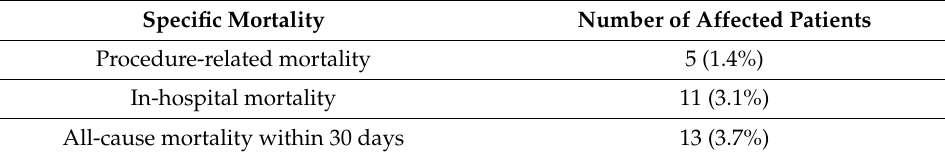
Table 4. Mortality after transvenous lead extraction.